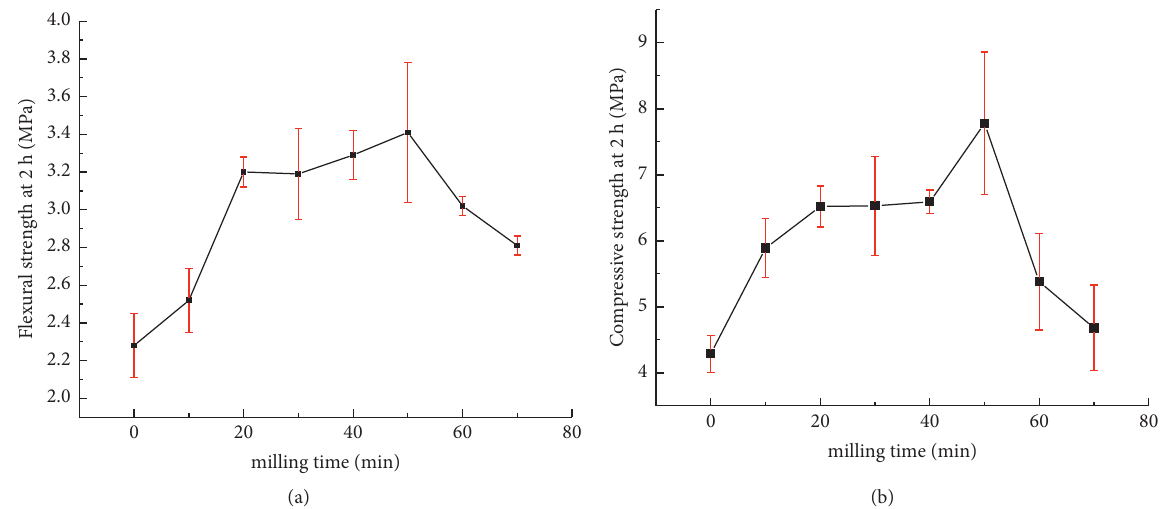
Figure 4: Variation of the 2h strength of PBG with milling time. (a) Flexural strength. (b) Compressive strength.